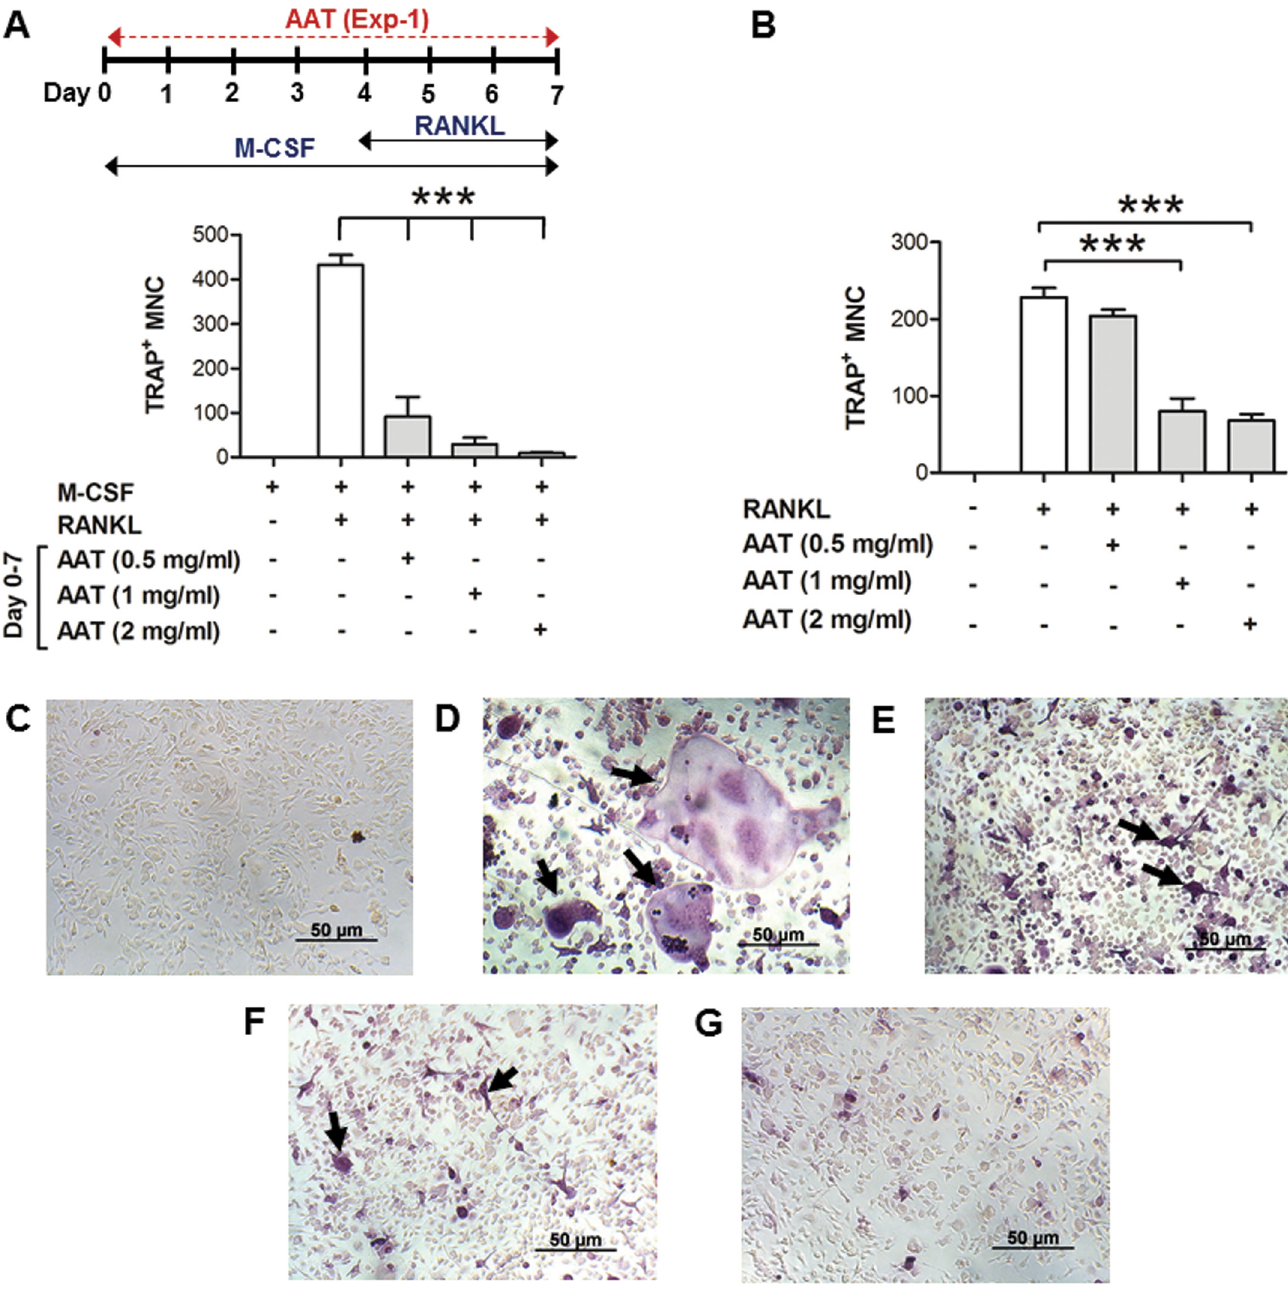
Figure 1. AAT inhibits RANKL-induced osteoclast formation. (A) TRAP + multinuclear cells. MNCs (cell number/well of 96-well cell culture plate) derived from BMM cells. Top diagram, experimental design. Different concentrations of AAT were added during RANKL-induced osteoclast formation (Exp-1, d 0–7). (B) TRAP + MNCs (cell number/well of 96-well cell culture plate) derived from RAW 264.7 cells. Here, osteoclasts were generated with RANKL for 6 d with or without different concentrations of AAT as indicated. (C–G) Representative images of TRAP + MNCs shown in (A): (C) M-CSF only (considered as negative control); (D) RANKL + M-CSF (considered as positive con- trol); (E) RANKL + M-CSF + AAT (0.5 mg/mL); (F) RANKL + M-CSF + AAT (1 mg/mL); (G) RANKL + M-CSF + AAT (2 mg/mL). Values are means ± SEM of at least triplicate samples. Data were analyzed using one-way analysis of variance followed by Dunnett’s multiple comparison test. *** P <0.0001. Scale bar, 50 μ m. The arrow indicates multinuclear osteoclast